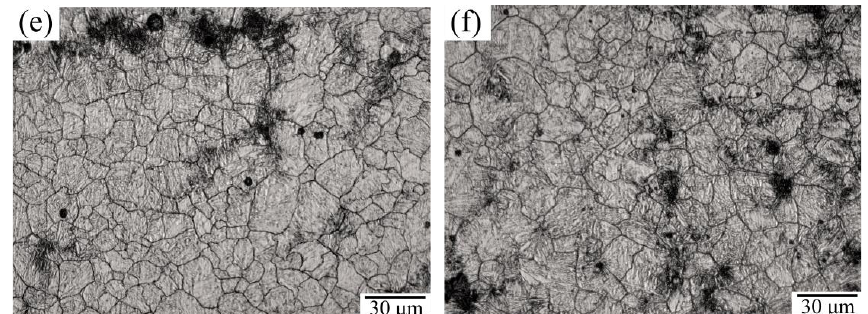
Figure 6. Grain size etching diagram. ( a ) Control group T0; ( b ) group T1; ( c ) group T2; ( d ) group T3; ( e ) group T4; ( f ) group T5.